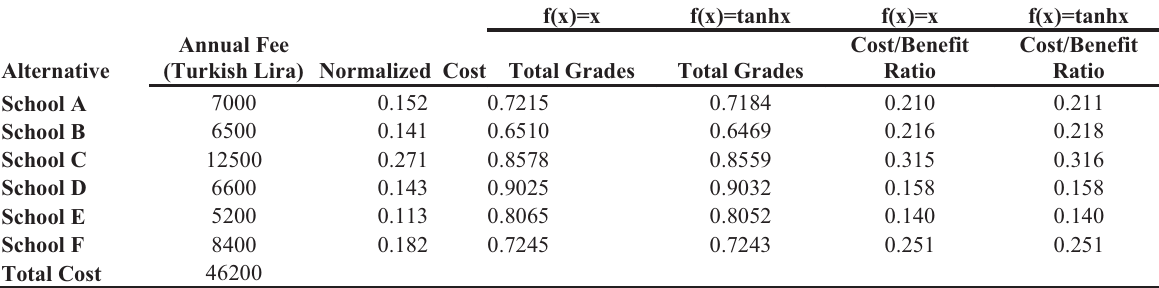
Table 13. Cost/Benefit analysis of the